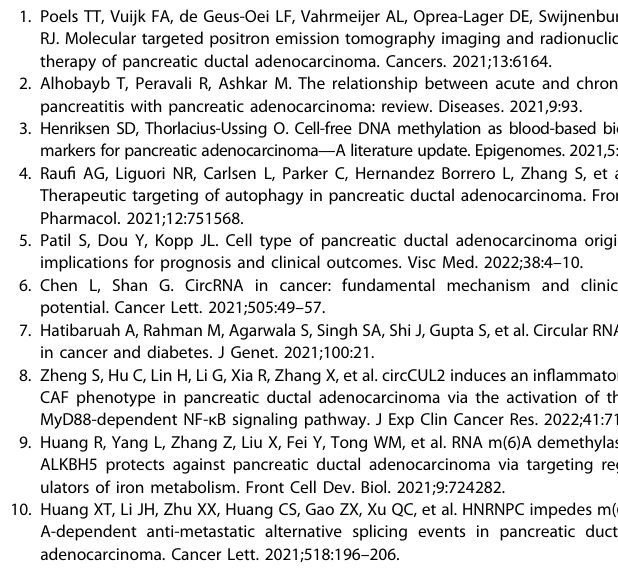
Fig. 7 m 6 A-modi fi ed circMYO1C enhances PD-L1 mRNA stability through interacting with IGF2BP2. CircMYO1C highly expressed in PDAC, and circMYO1C cyclization was mediated by m6A methyltransferase METTL3. circMYO1C targeted the m6A site of PD-L1 mRNA to enhance its stability through cooperating with IGF2BP2, thereby accelerating PDAC immune escape.